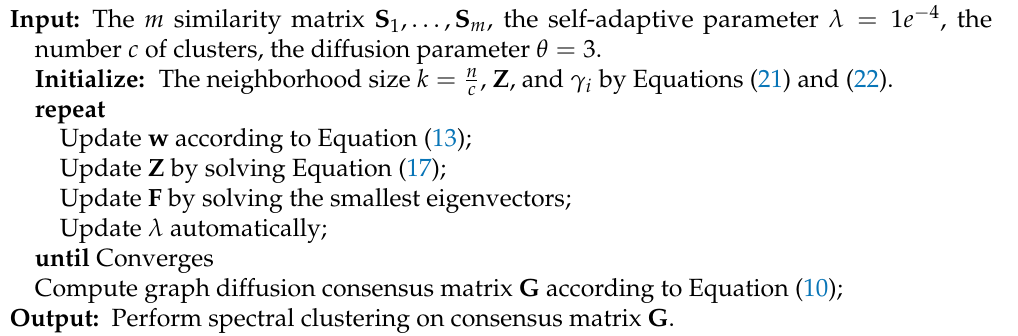
Algorithm 1 The algorithm of the proposed method.